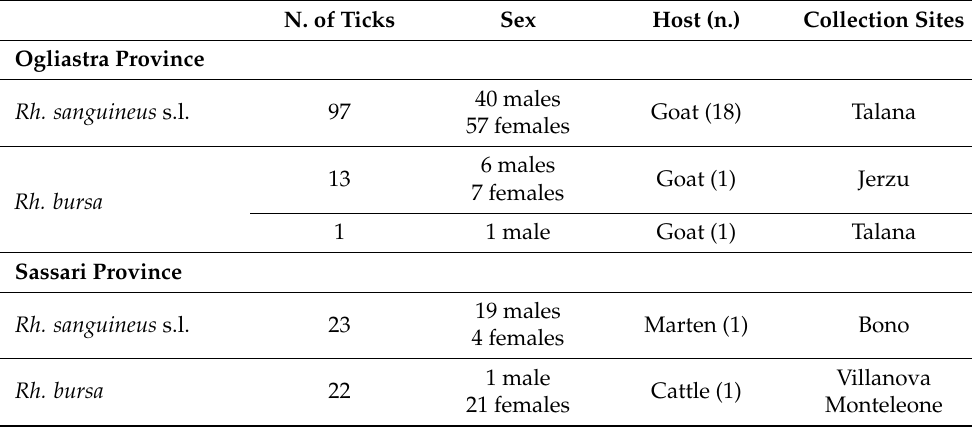
Table 1. Species, sex, hosts, and geographic areas from which ticks were collected. N. of Ticks Sex Host (n.) Collection